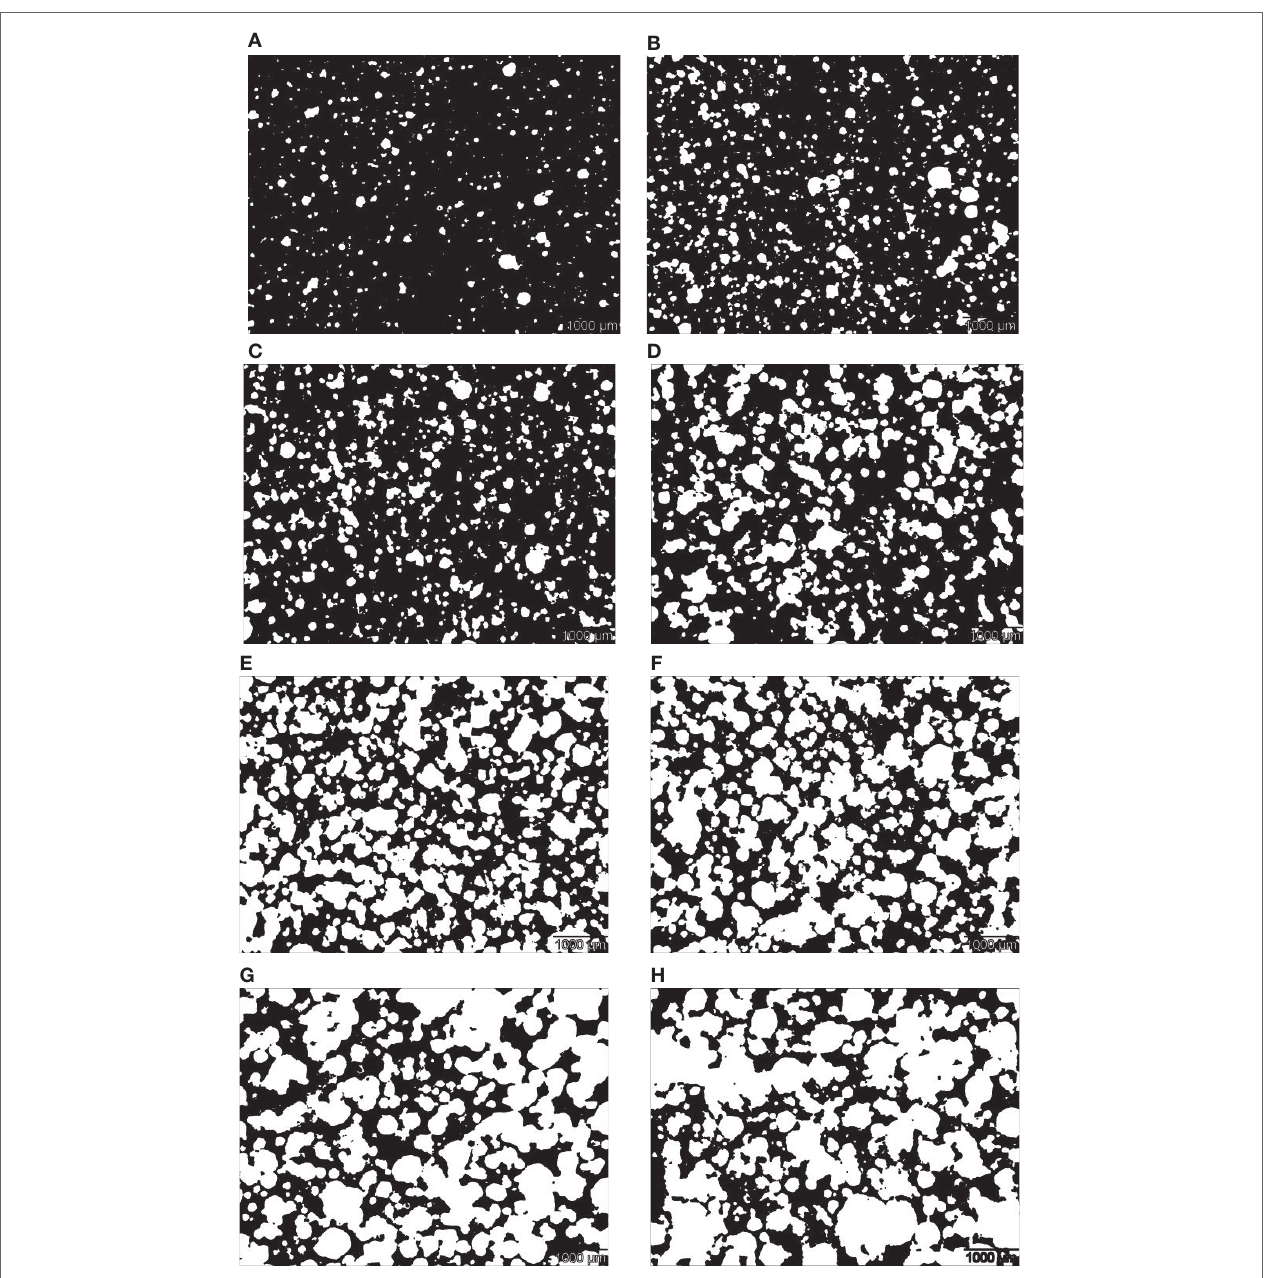
FigUre 2 | Typical ia images of gFcs with 0% (a), 1.3% (b), 3.3% (c), 5% (D), 6.7% (e), 10% (F), 13% (g), and 16% (h) of foam addition in respect of solid raw materials. The white areas are pores and the black areas are geopolymer binder. The scale bar is 1000 μ